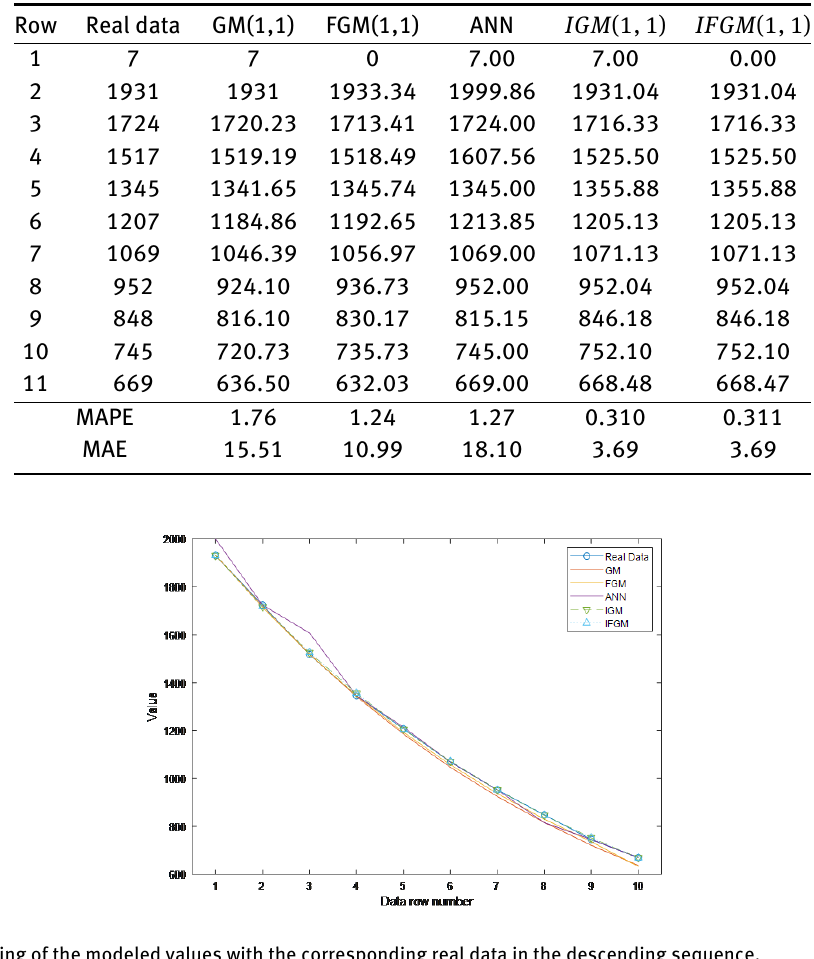
Figure 5: Matching of the modeled values with the corresponding real data in the descending sequence.